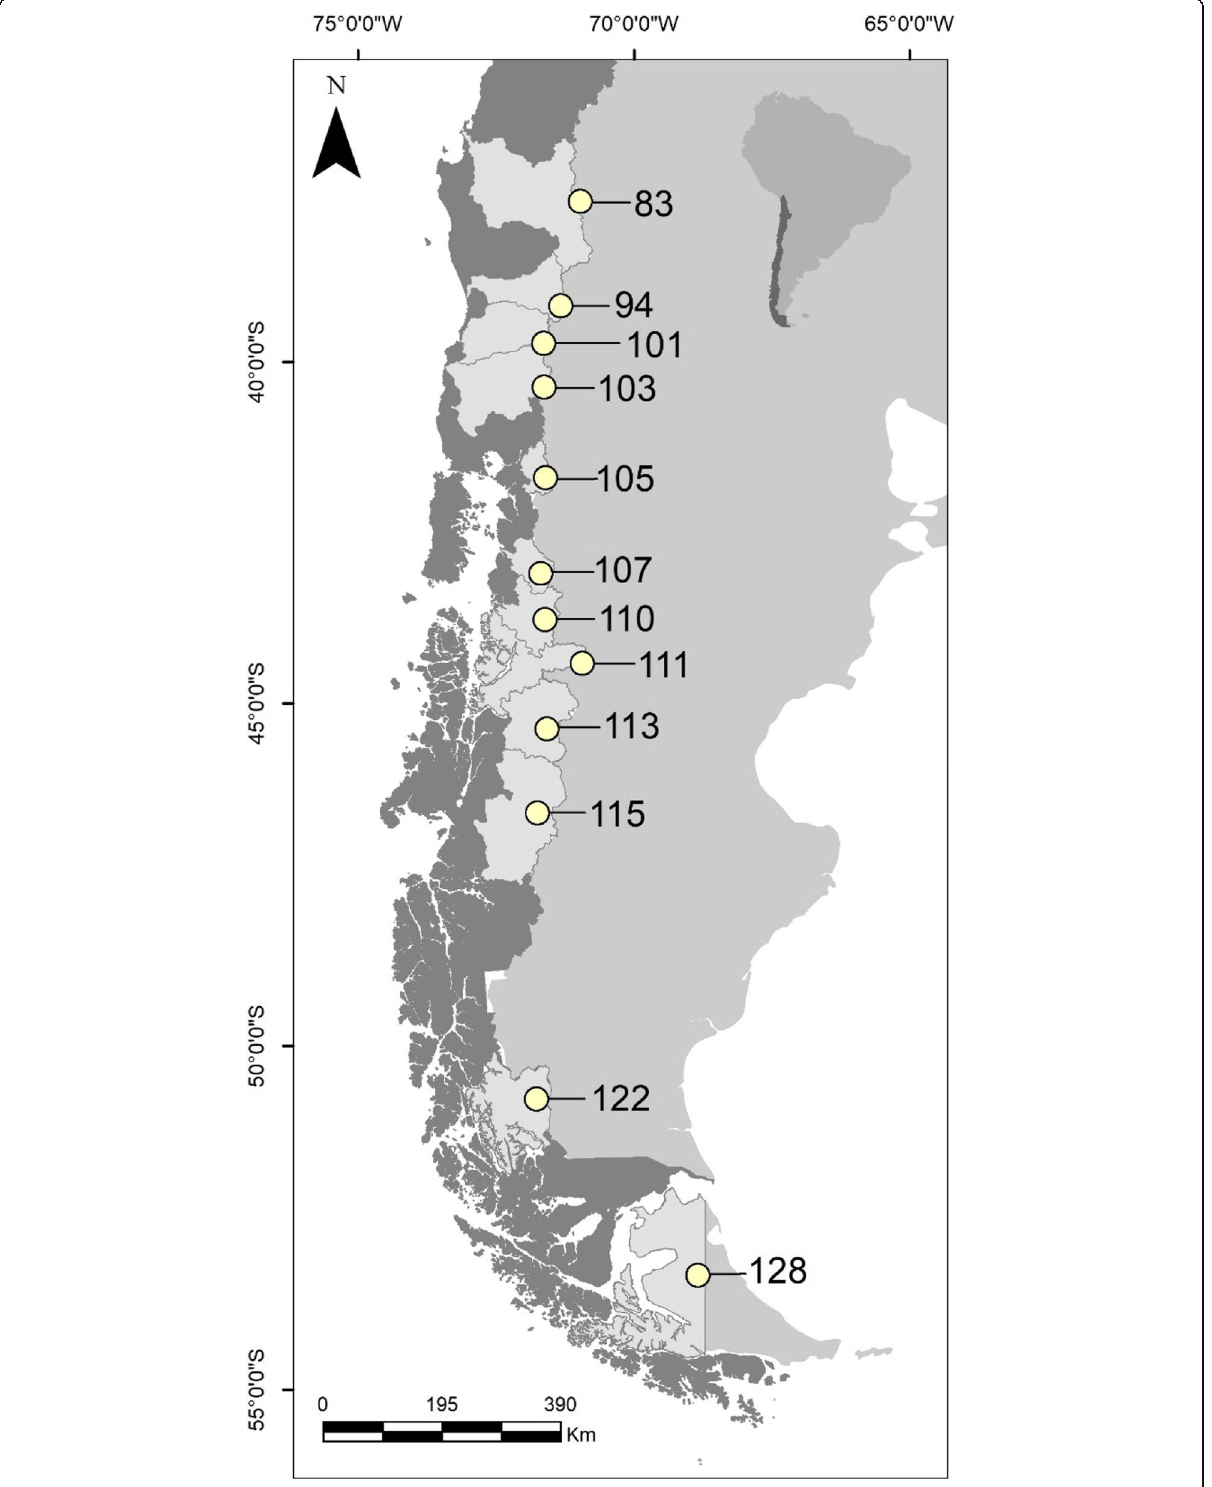
Fig. 1 Location of the basins included in this study, identified by code numbers. Biobio River Basin (83), Tolten River Basin (94), Valdivia River Basin (101), Bueno River Basin (103), Puelo River Basin (105), Yelcho River Basin (107), Palena and coastal Rivers in the Southern Limit of the Tenth Region River Basin (110), Coastal and Island Rivers Between Palena River and Aysen River Basins (111), Aysen River Basin (113), Baker River Basin (115), Coastal Rivers Between Seno Andrew and Hollemberg River and Rivers to the East River Basins (122), and Tierra del Fuego